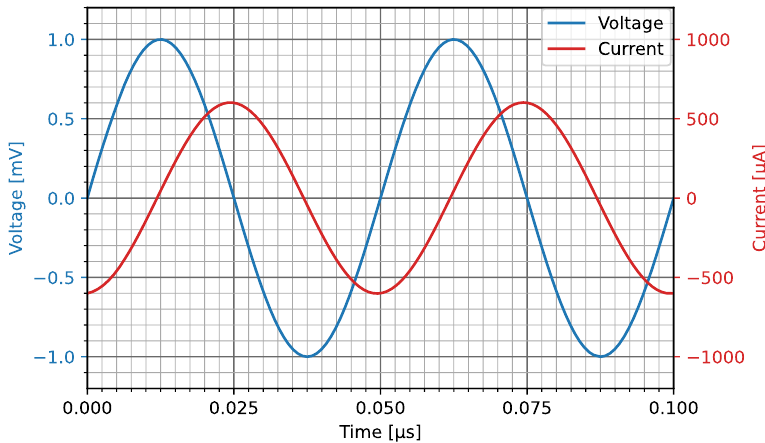
Figure 36. Simulated voltage and current curves (1 mV, 20 MHz input signal